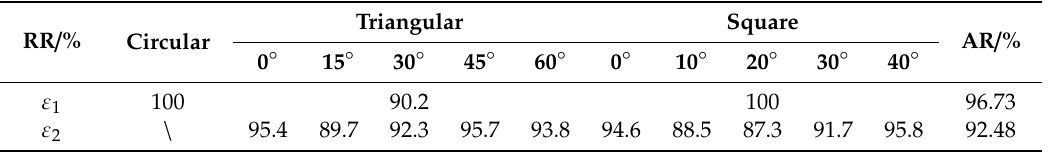
Table 2. Classification results of the support vector machine (SVM) method based on chaotic features (CF)-power spectrum density (PSD) features.